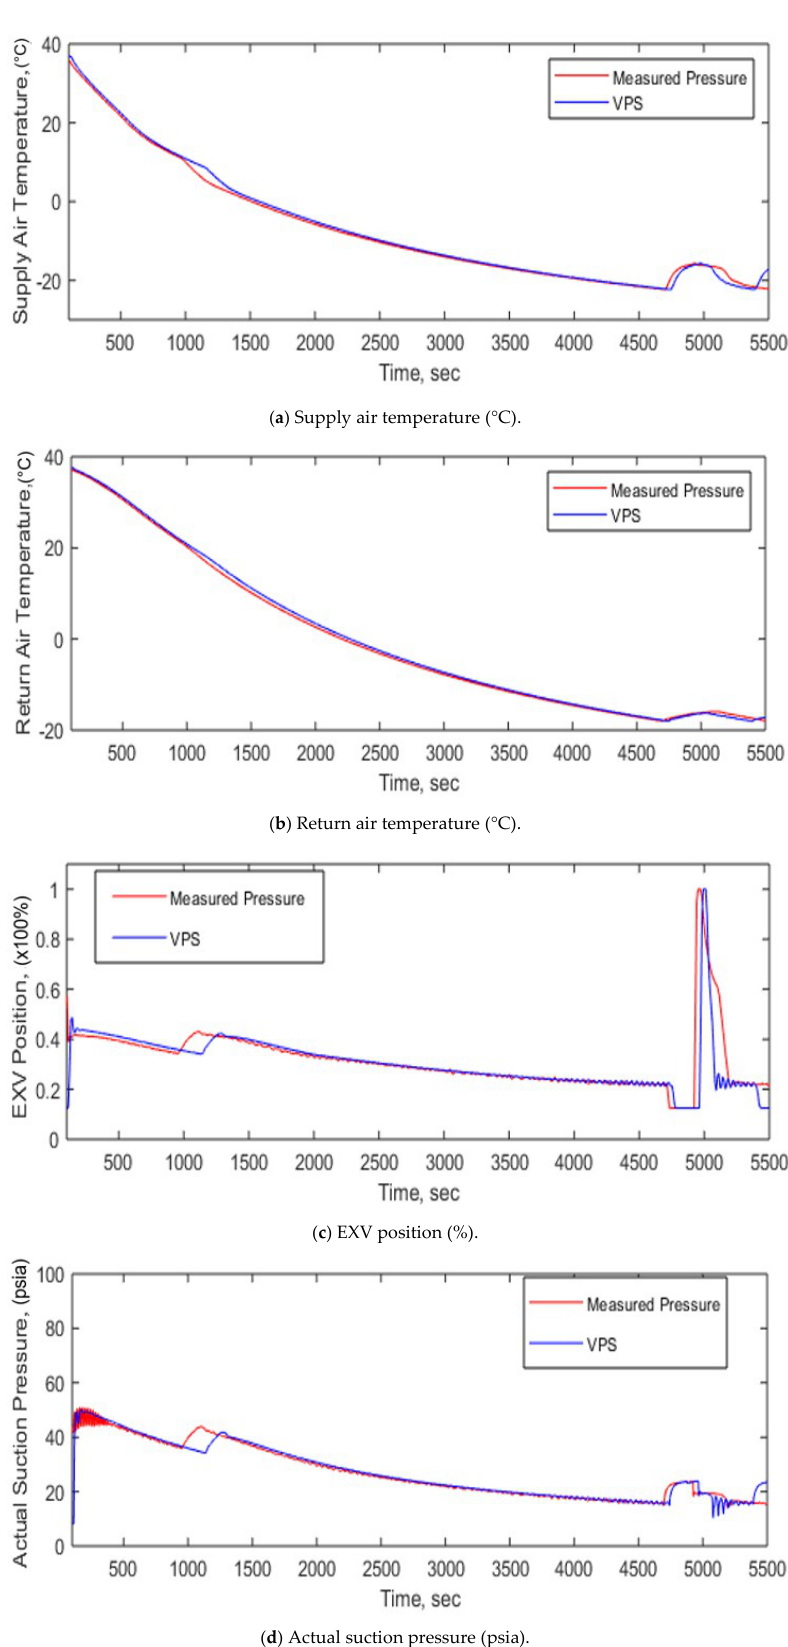
Figure 9. MIL simulation results for scenario 2.